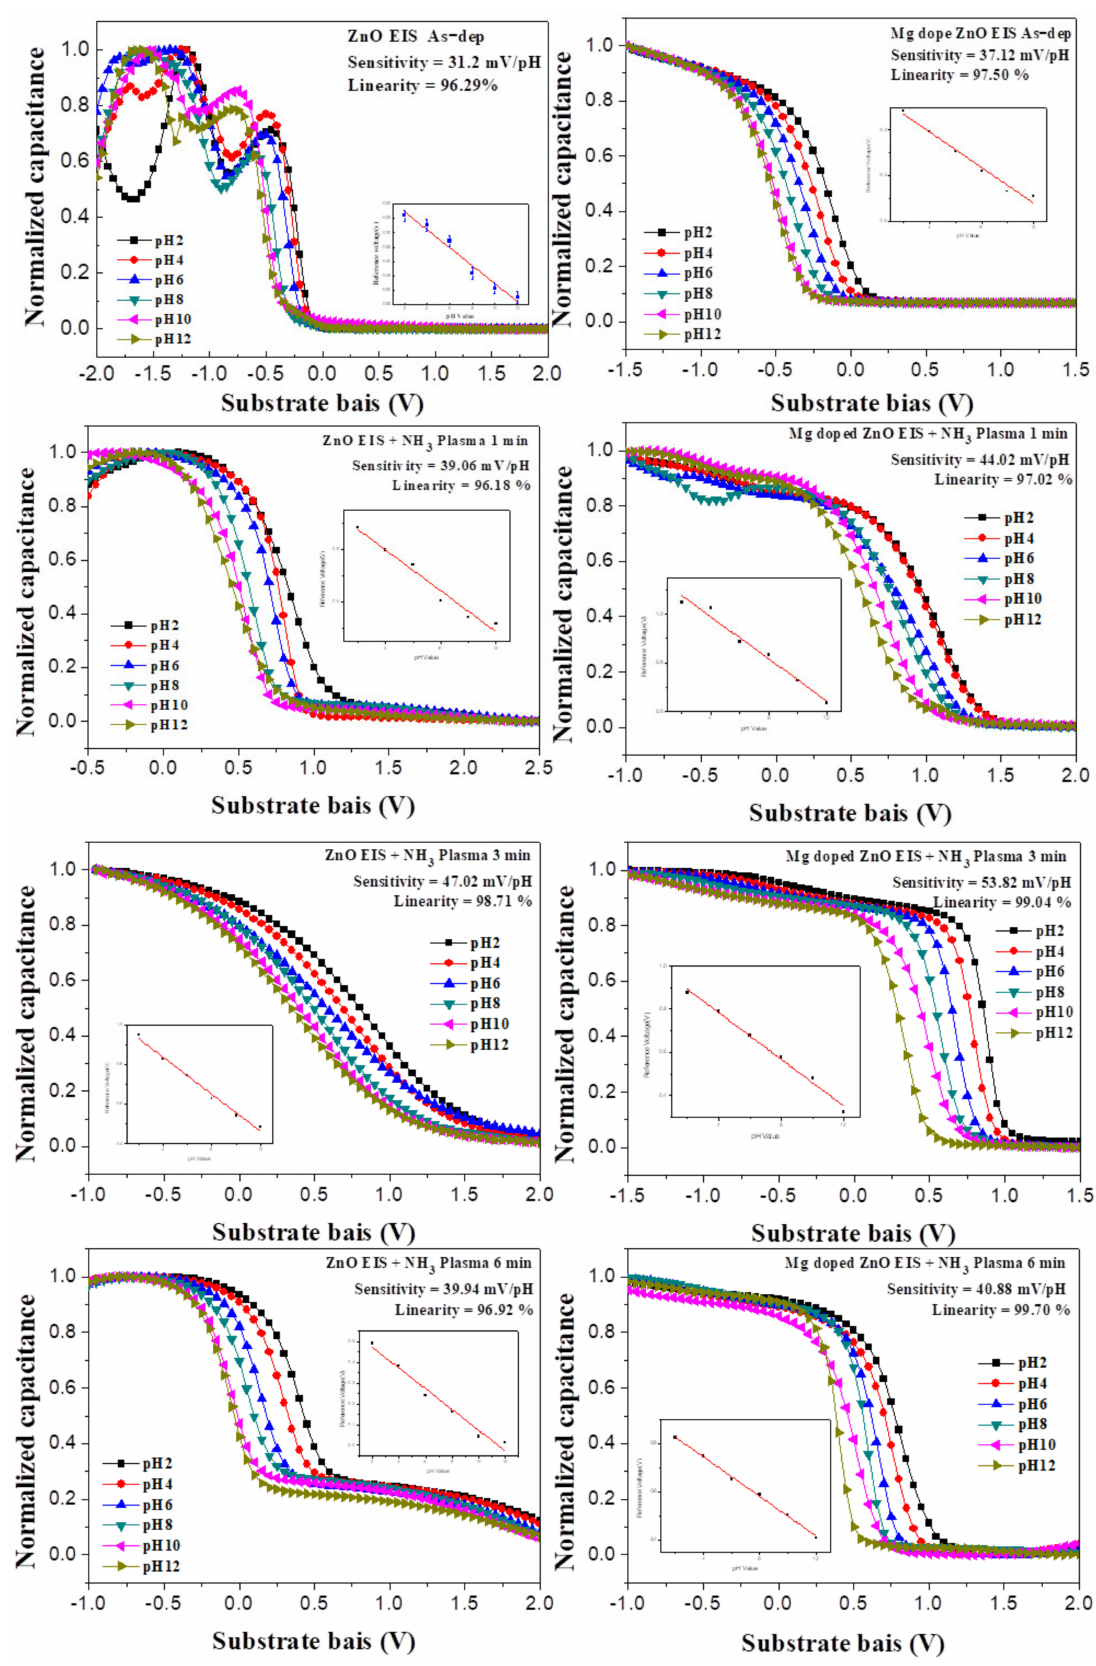
Figure 5. The output characteristics (C–V curve) of the ZO and MZO, with and without NH 3 plasma treatment, under various factors, were observed in a bu ff er solution, from pH 2 to pH